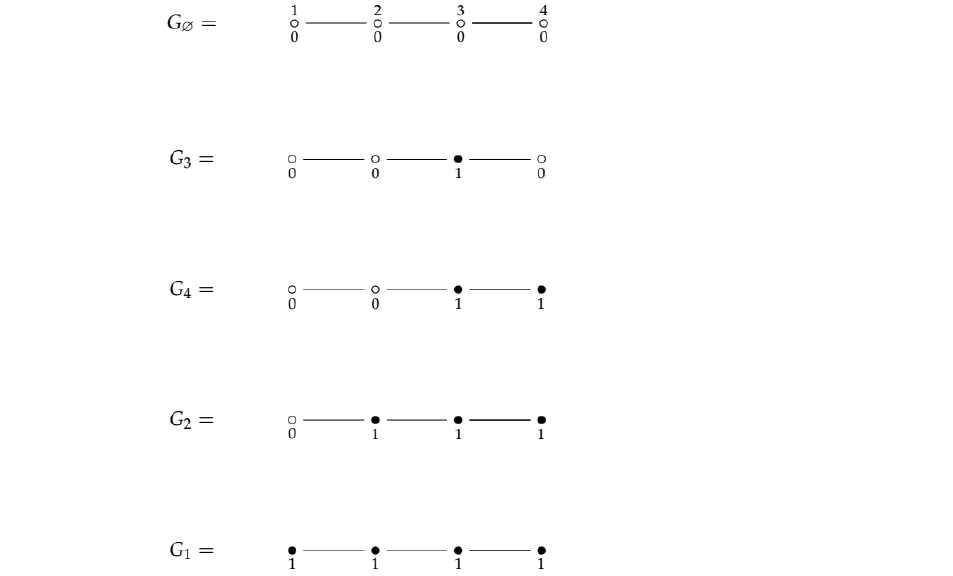
Figure 4. We apply Bert Kostant’s game to the Dynkin diagram A 4 . Symbol G i , 1 vertex i of the Dynkin diagram A 4 receives one chip (associated vertices are black). G ∅ means that no vertex of the diagram receives a chip (associated vertices are all